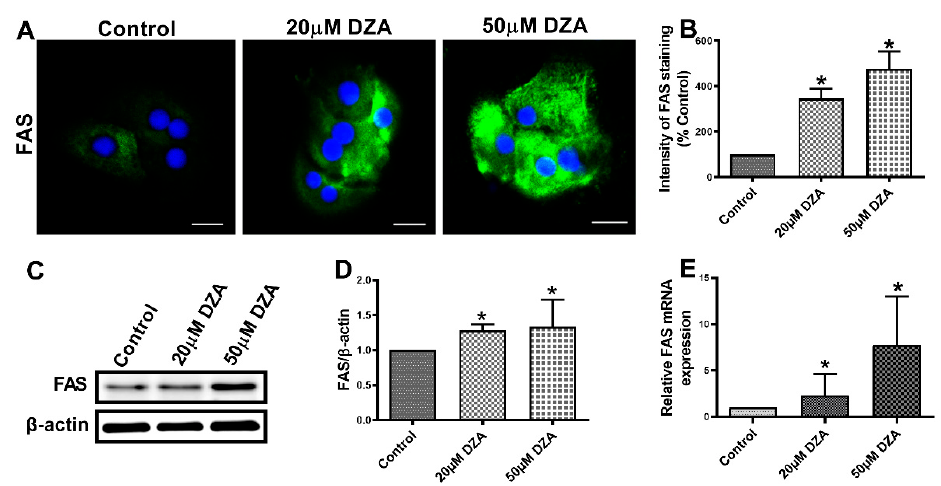
Figure 4. FAS expression in control and DZA-treated hepatocytes. ( A ) Images of FAS staining in representative control and DZA-treated hepatocytes; (scale bar 20 µ m). ( B ) The fluorescence intensity of FAS expression normalized to % of control cells, n = 3 experiments; images of 30 random cells from each treatment group per experiment were captured and analyzed. ( C ) Representative Western blot showing FAS levels in control and DZA-treated cells. ( D ) Immunoblot analysis summarizing the protein band density of FAS to β -actin, n = 3 experiments. ( E ) Relative FAS mRNA expression in control and DZA-treated hepatocytes, n = 7 experiments. Asterisks indicate values for DZA-treated hepatocytes are statistically di ff erent from controls (* p ≤ 0.05 vs. Control).